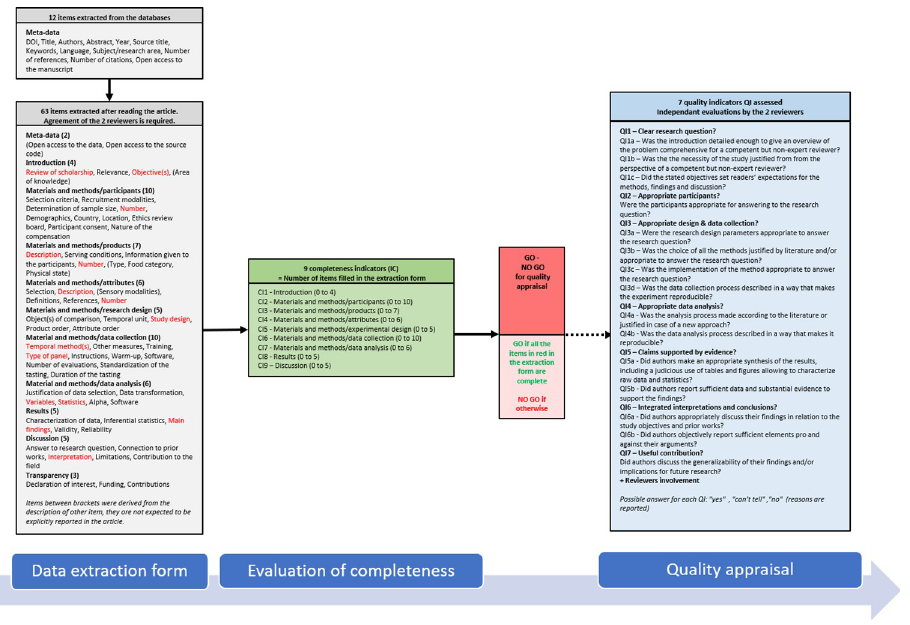
Fig 2. Summary of the process of